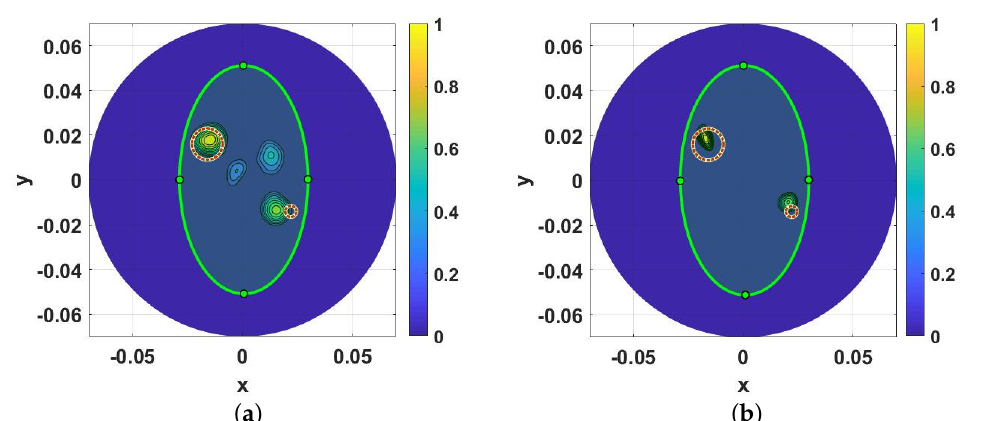
Figure 7. Reconstructed images of the lung phantom with two inclusions. ( a , b ) represent the images corresponding to applying the “rotation subtraction” artifact removal method and “ideal” artifact removal method, respectively. The light green ellipse indicates the phantom region, while the areas marked with red circles show the exact positions of the inclusions and the dimension of each circle is in relation to the dimension of the inclusion. Axes’ scales are